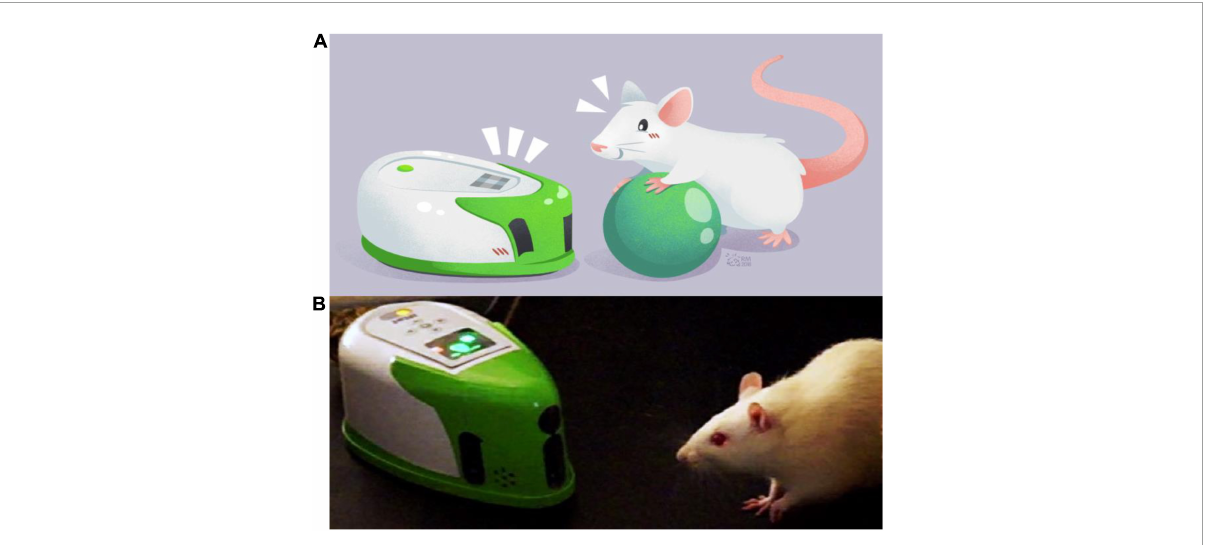
FIGURE1 (A) An artist’s depiction of rat–robot and rat–object interactions from Quinn et al. (2018) (Photo credit with permission from Rosana Margarida Couceiro). (B) A picture of live rat–robot